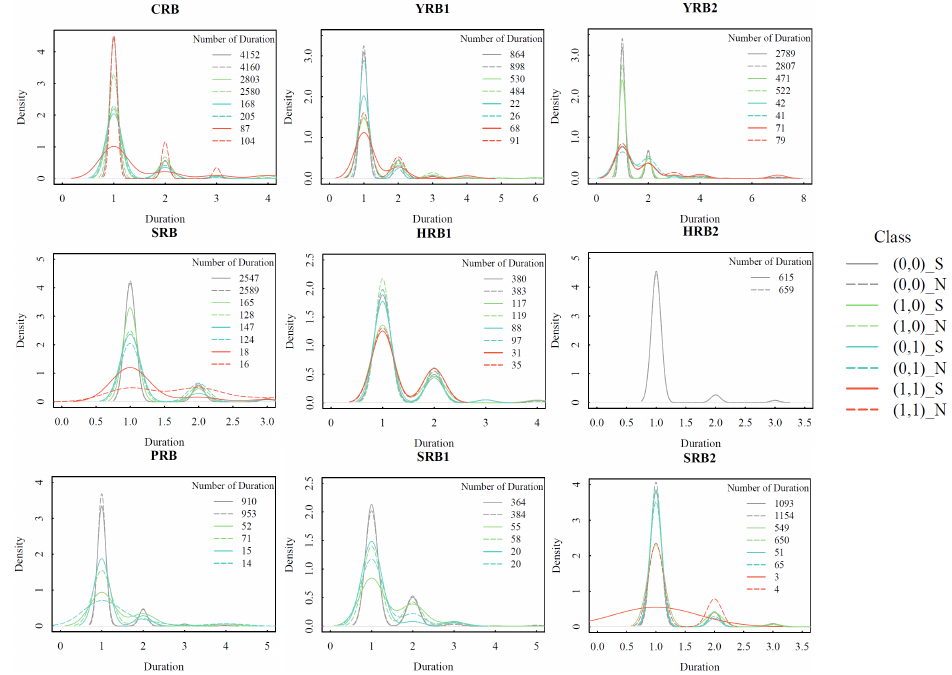
Figure 8. Probability density of duration estimated by SPEI and NSPEI in the nine river basins of China under different classifications of ( μ , σ ) changes in the fall–winter season.